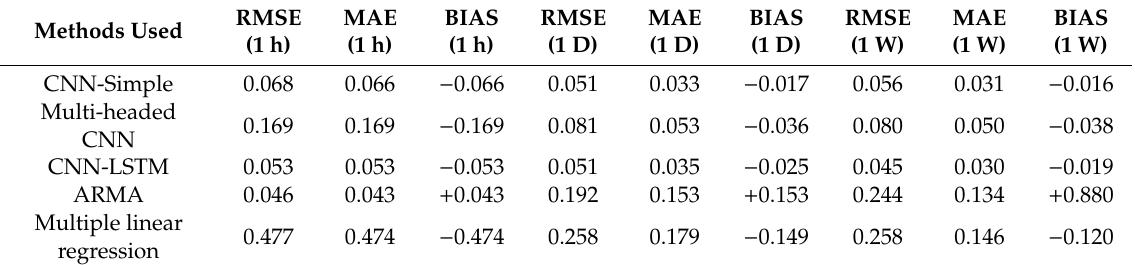
Figure 7. Model fitting test and train loss minimization for the CNN-LSTM